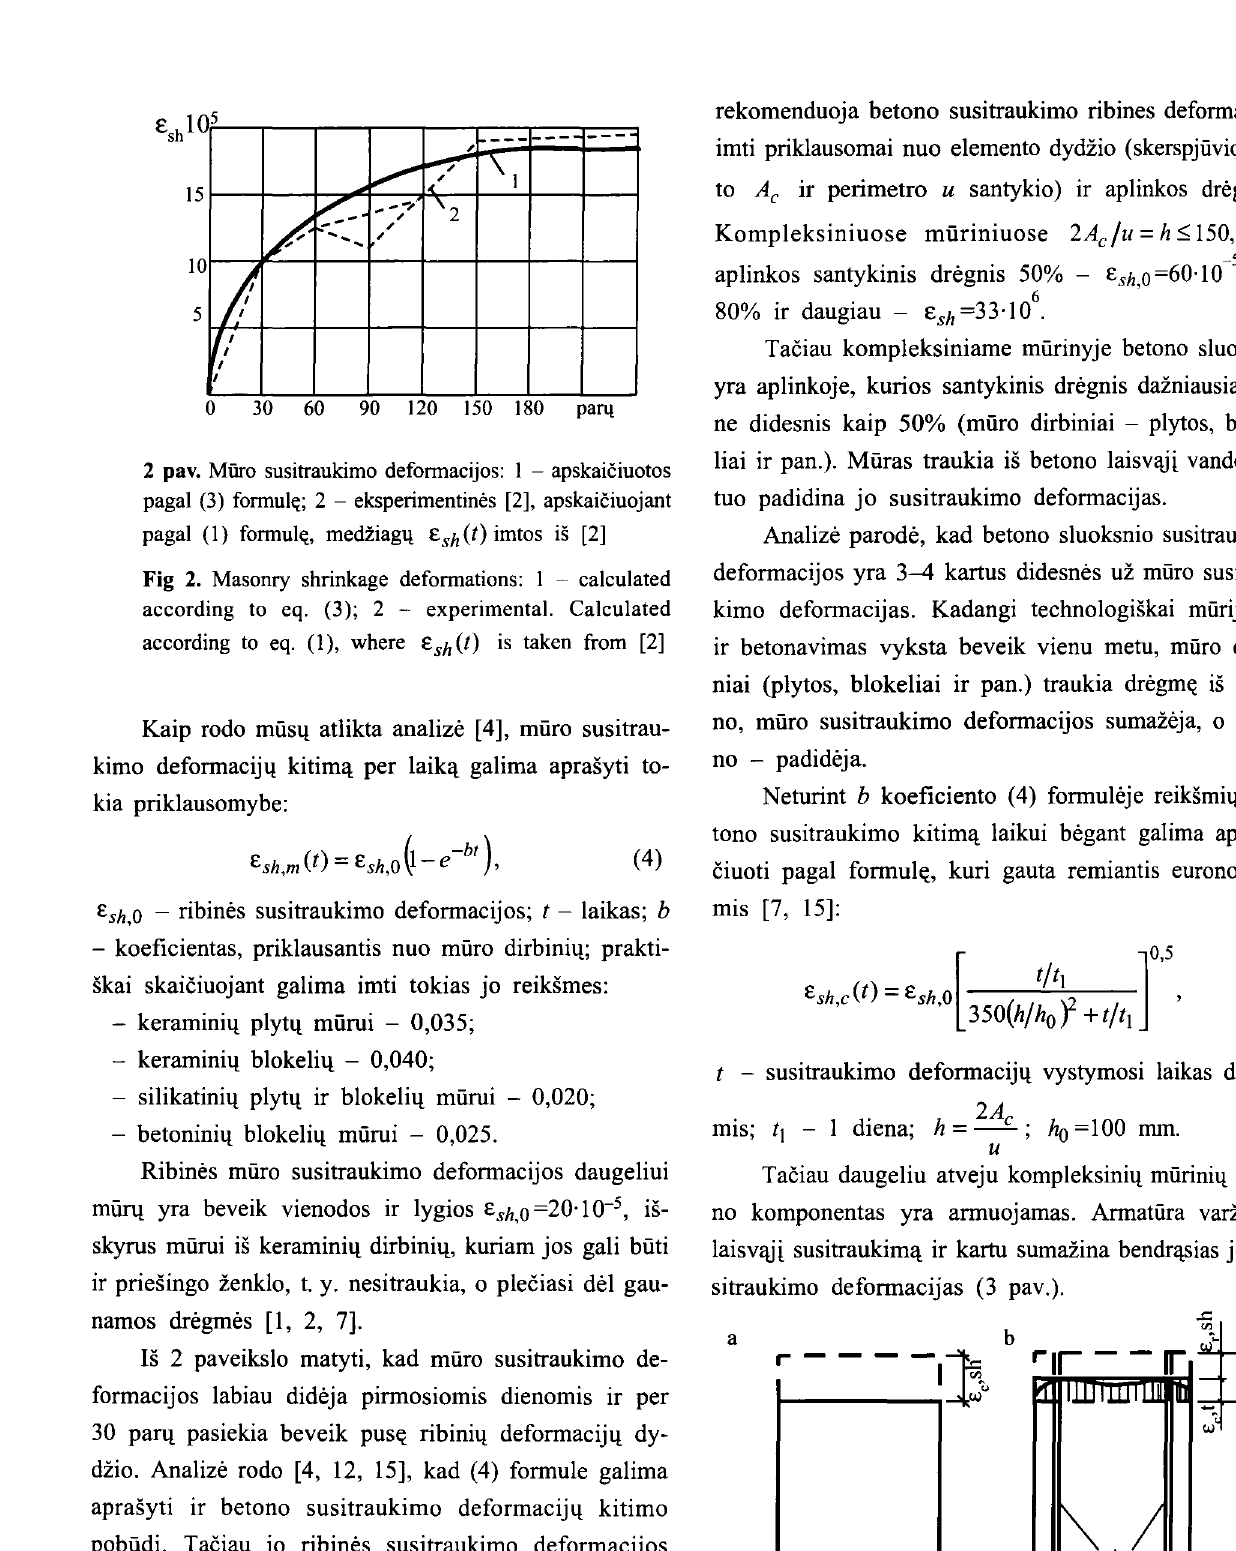
Fig 3. Shrinkage diagrams of non-reinforced (a) and reinforced (b) concrete used in experiments by most